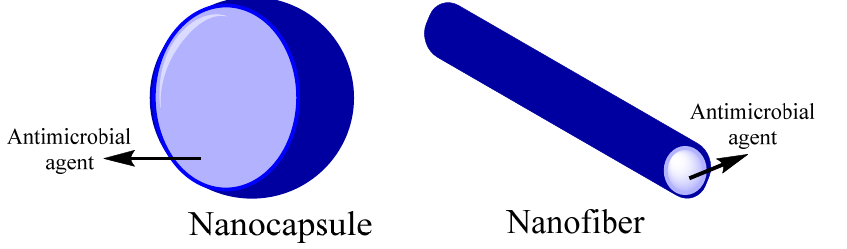
Figure 3. Biopolymer nanocarriers structures for encapsulation of antimicrobial agents.